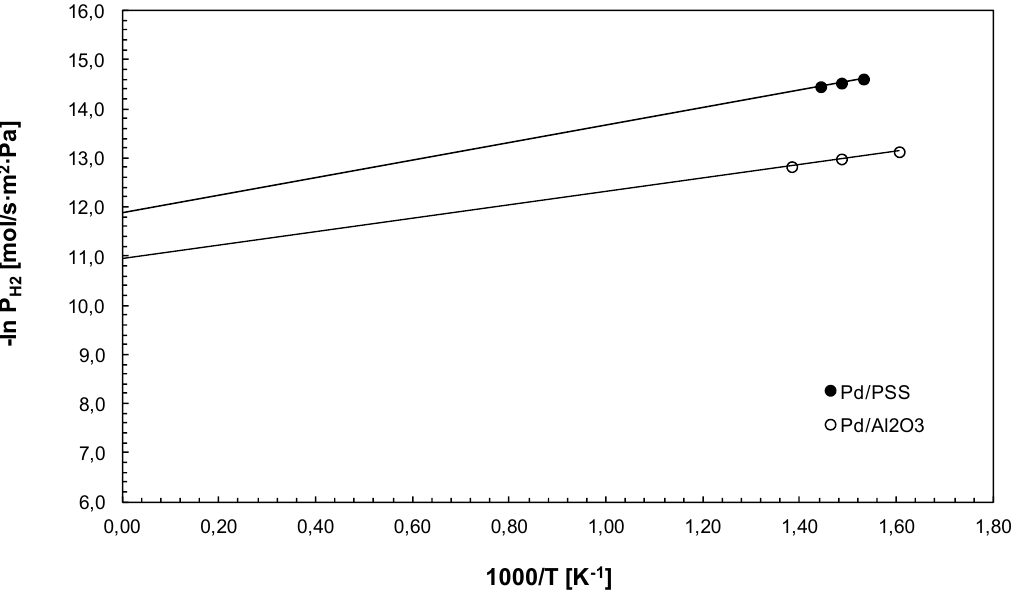
Figure 5. Arrhenius plot for pure hydrogen permeation tests using Pd/PSS and Pd/Al membranes at ∆ p = 1 bar.